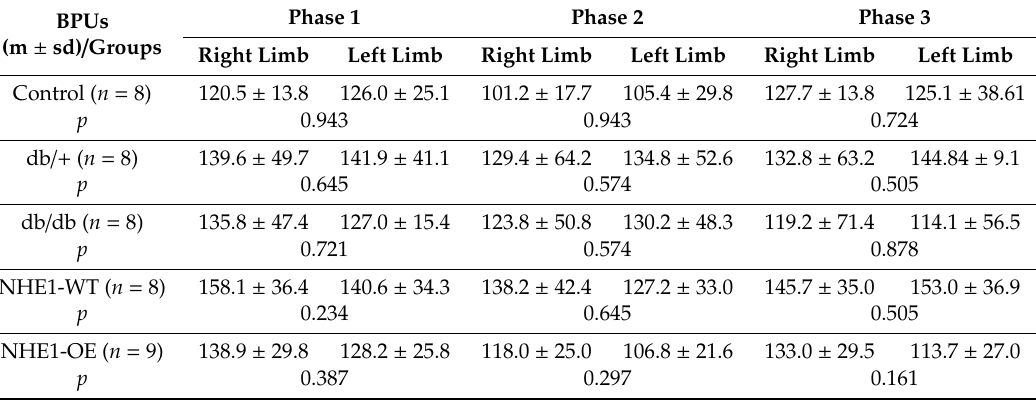
Table 1. Mean hind limb perfusion changes, expressed in BPUs (arbitrary blood perfusion units) registered in the left and right hind limb of each animal group during the experimental protocol (see text). Statistical comparison between hind limbs is shown in each phase of the protocol (m ± sd: mean ± standard deviation; * p <